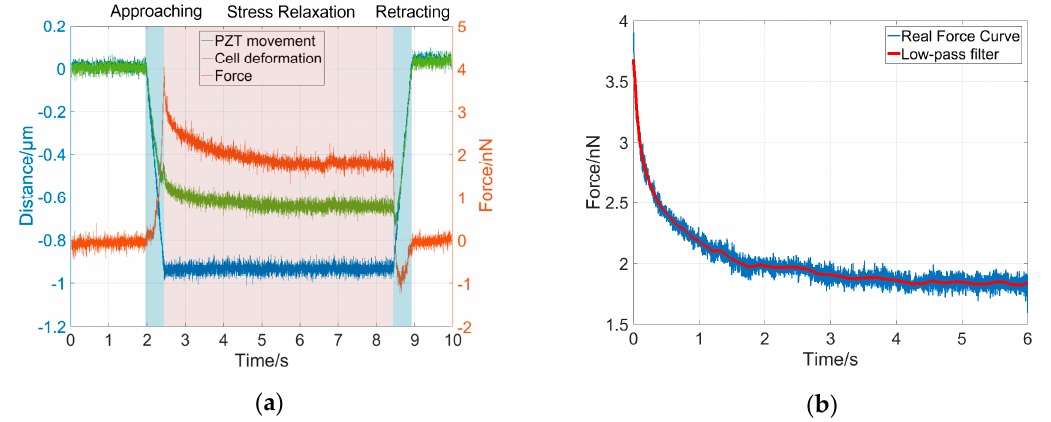
Figure 3. Illustration of the experimental curve from one entire indentation process. ( a ) The entire indentation process showing the changes in the z -position of piezoelectric (PZT) (blue), cell deformation (green), and interaction force (red) that the AFM measures during the three interaction phases; ( b ) Original force curve (blue) in the stress-relaxation phase and smoothed curve using a low-pass filter.